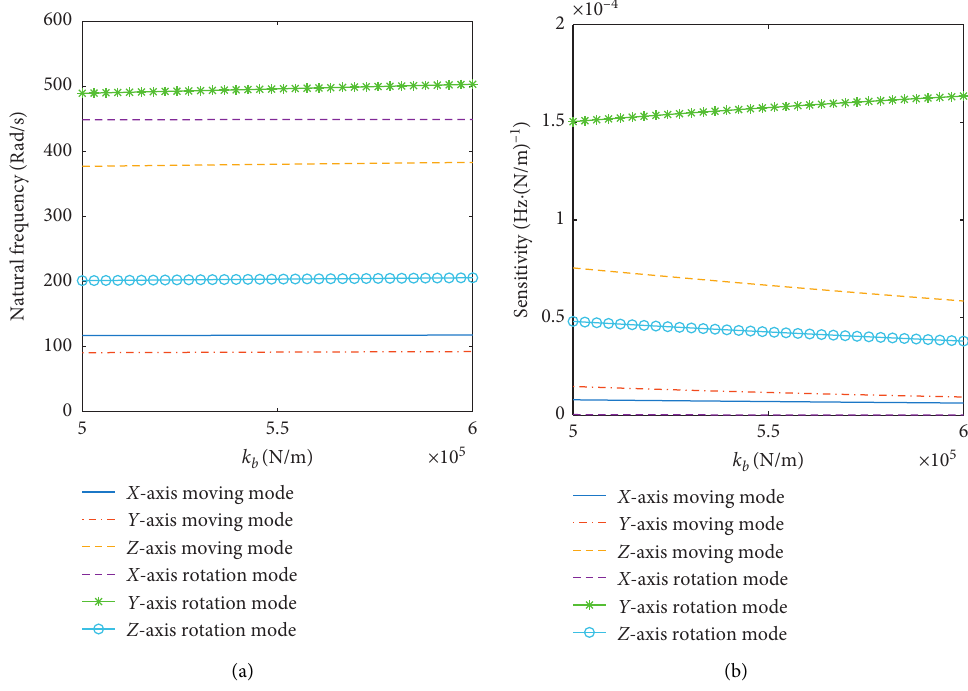
Figure 10: Curve of variation of natural frequency and its sensitivity with stiffness of outer leg 2. (a) Natural frequency. (b) Sensitivity of natural frequency to the stiffness of outer leg